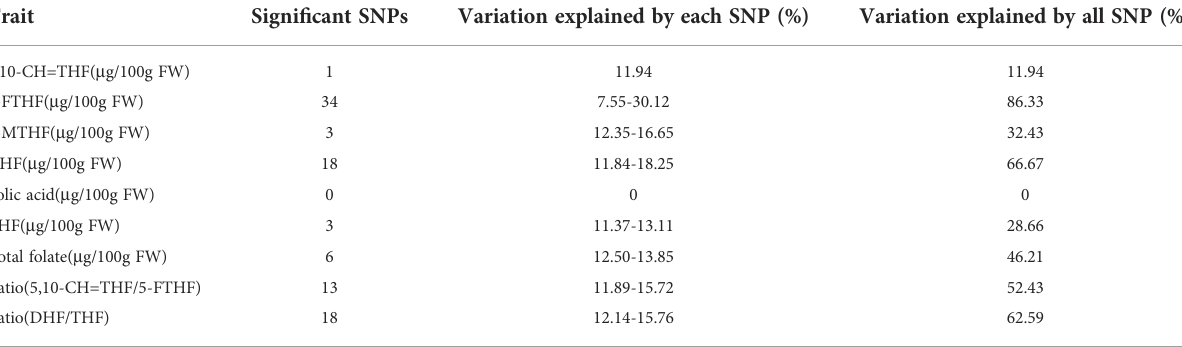
TABLE 2 Summary of signi fi cant SNPs identi fi ed for folates traits in sweet corn. Trait